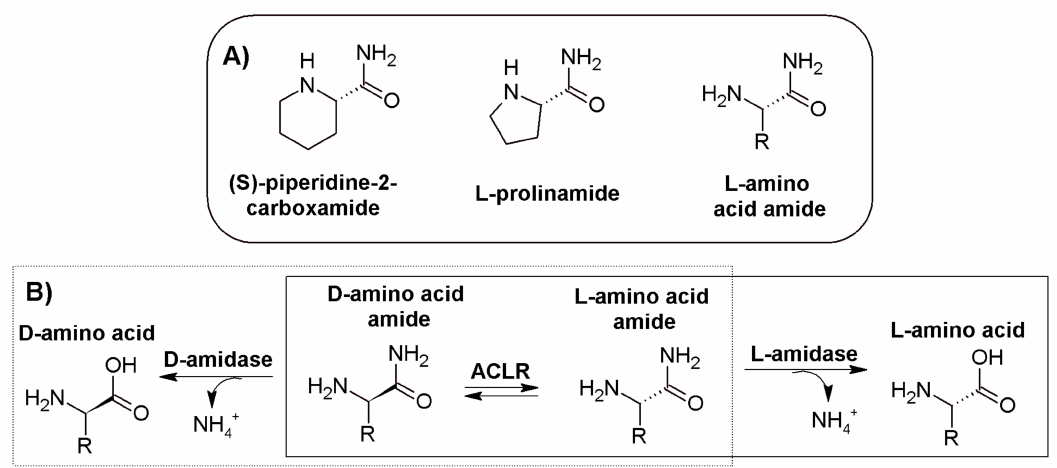
Figure 1. ( A ) Substrates recognized by L-proline amide hydrolase. ( B ) General scheme of the “Amidase Process”. The full line represents the “L-system”, whereas the dashed line represents the “D-system”. ACLR: α -amino- ε -caprolactam